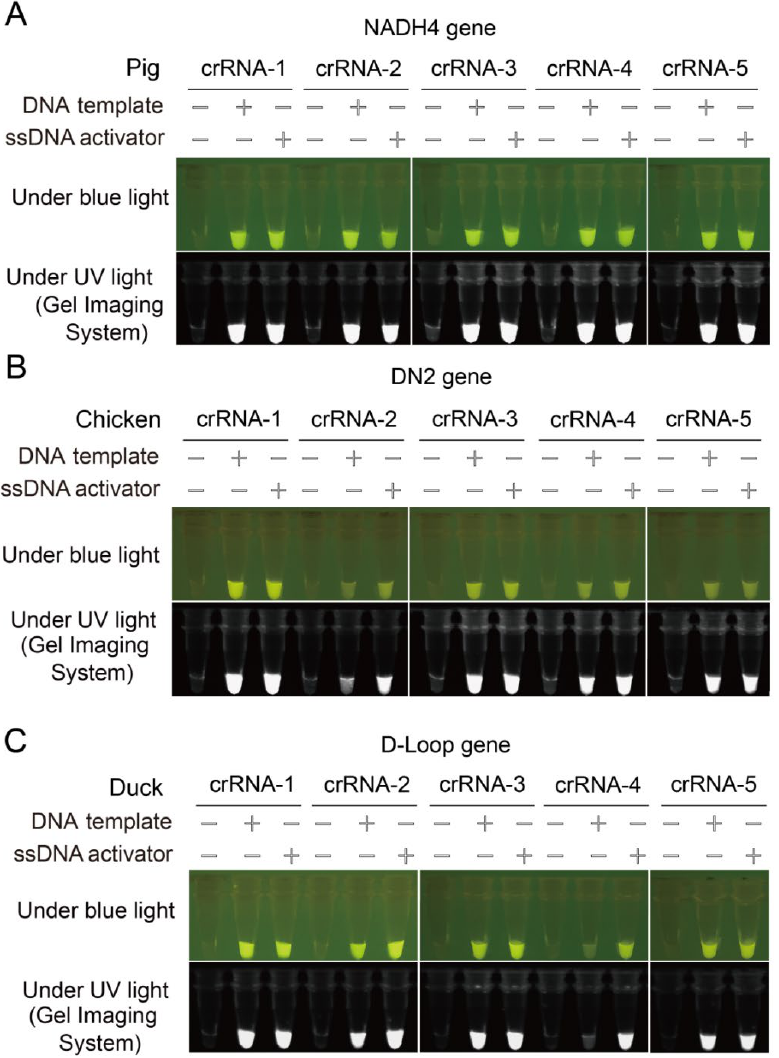
Figure 1. Identification of the highly active crRNAs for detection of pork, chicken and duck meat using CRISPR-Cas12a fluorescence assay. Identification of highly active crRNAs for visual detection of ( A ) the pork NADH4 gene, ( B ) the chicken ND2 gene and ( C ) the duck D-Loop gene. crRNA–1, crRNA–2, crRNA–3, crRNA–4 and crRNA–5 represent different crRNAs targeting the NADH4 , DN2 and D-Loop genes. DNA templates represent the PCR amplicons of NADH4, DN2 or D-Loop genes. ssDNA activator is a crRNA-complementary ssDNA. Images captured using a smartphone camera under blue (470 nM) and ultraviolet